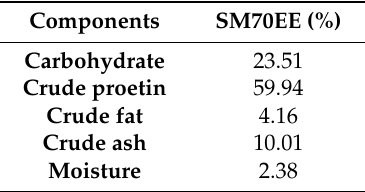
Table 1. Composition of